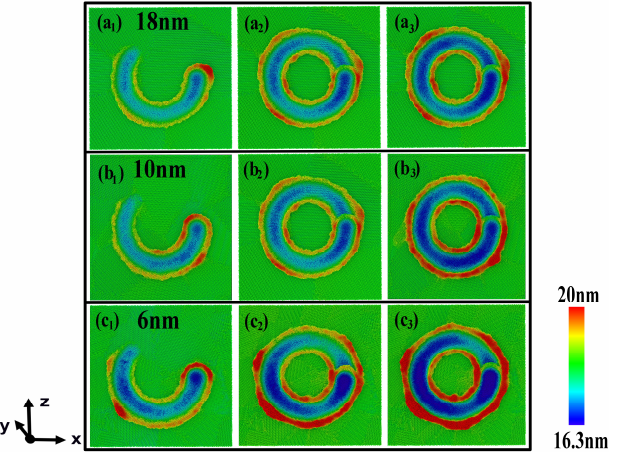
Figure 14. Surface topography of workpiece with different grain size after three frictions, the grain size of the workpieces from (a–c) are 18 nm, 10 nm, and 6 nm respectively, and a1 , b1 , c1 are the first friction of the grinding ball, a2 , b2 , c2 are the second friction and a3 , b3 , c3 are the third friction.